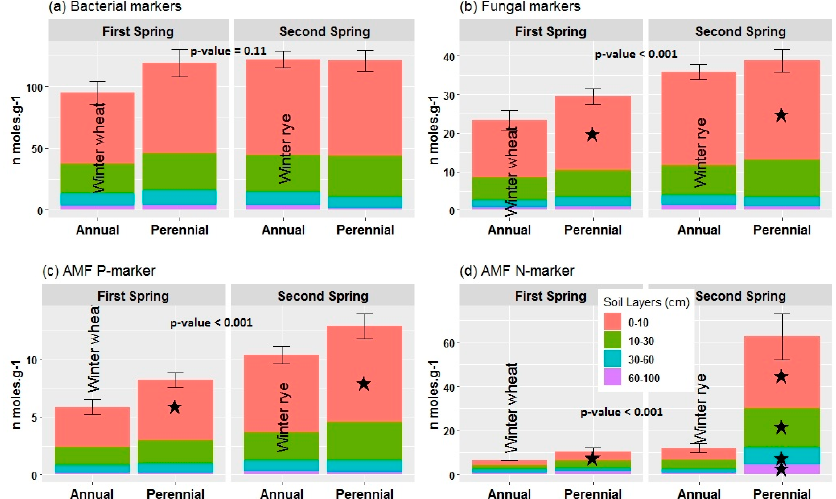
Figure 5. The PLFA and NLFA markers in annual wheat and intermediate wheatgrass, and between annual rye and the intermediate wheatgrass during the first and second growing seasons. Statistical differences (post hoc analyses) between annual and perennial grains are indicated by ★ . Error bars indicate standard errors, from 0 to 100 cm depth.